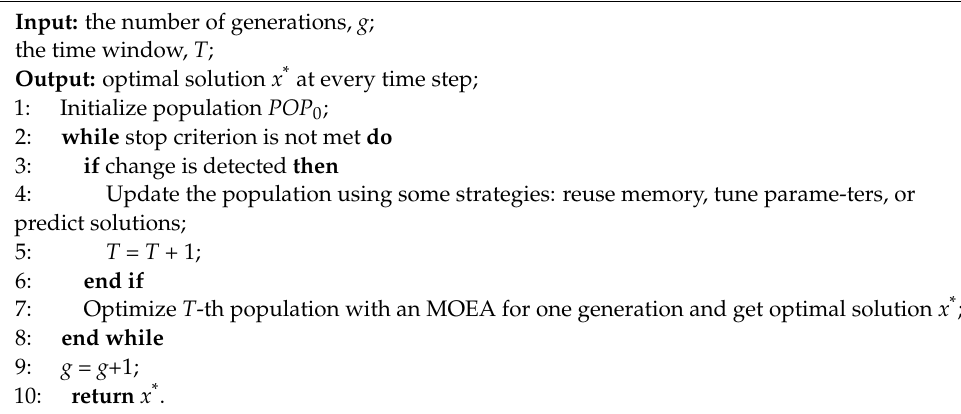
Algorithm 1 The main frame of